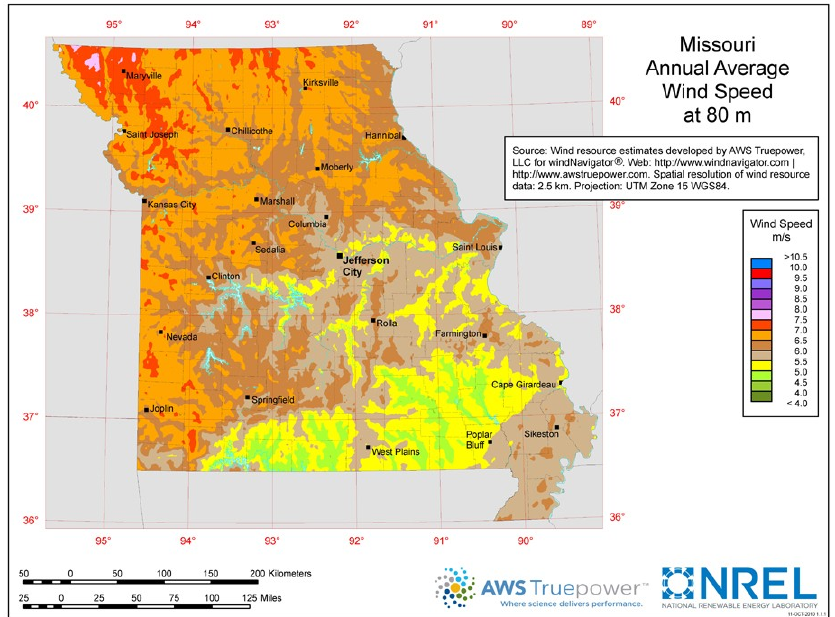
Figure 8. DOE wind speed data for Missouri at 80 m elevation (wind resources developed by ASW Truepower, LLC (http://www.awstruepower.com, accessed 12 August 2022) for windNavigator ® (http://windnavigator.com, accessed 12 August 2022)).